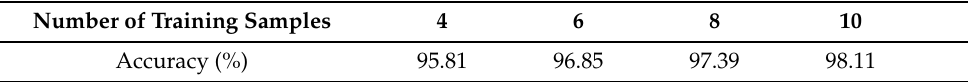
Table 4. The recognition accuracy for different number of training samples.